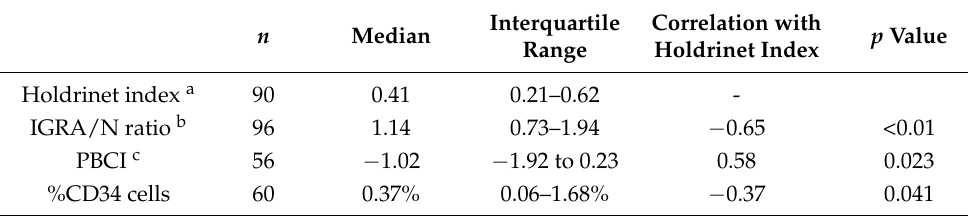
Table 2. Bone marrow hemodilution in patients with multiple myeloma after